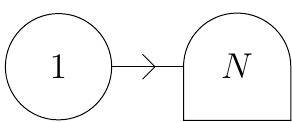
Figure 8 . The quiver diagram for the simple surface operator of type [1 ; N (cid:0) 1] in the SU( N )